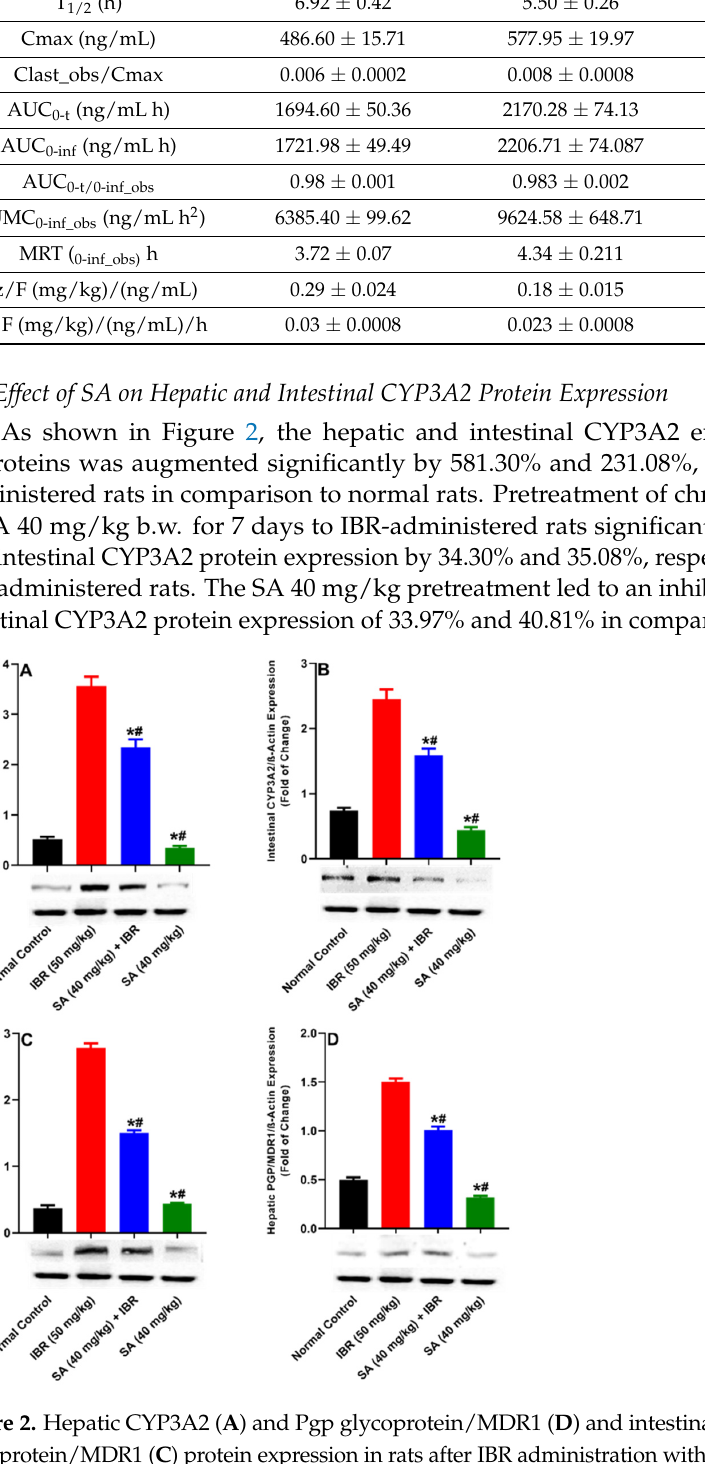
Table 1. Non-compartmental pharmacokinetic parameters of IBR and IBR + SA following oral administration in rats.